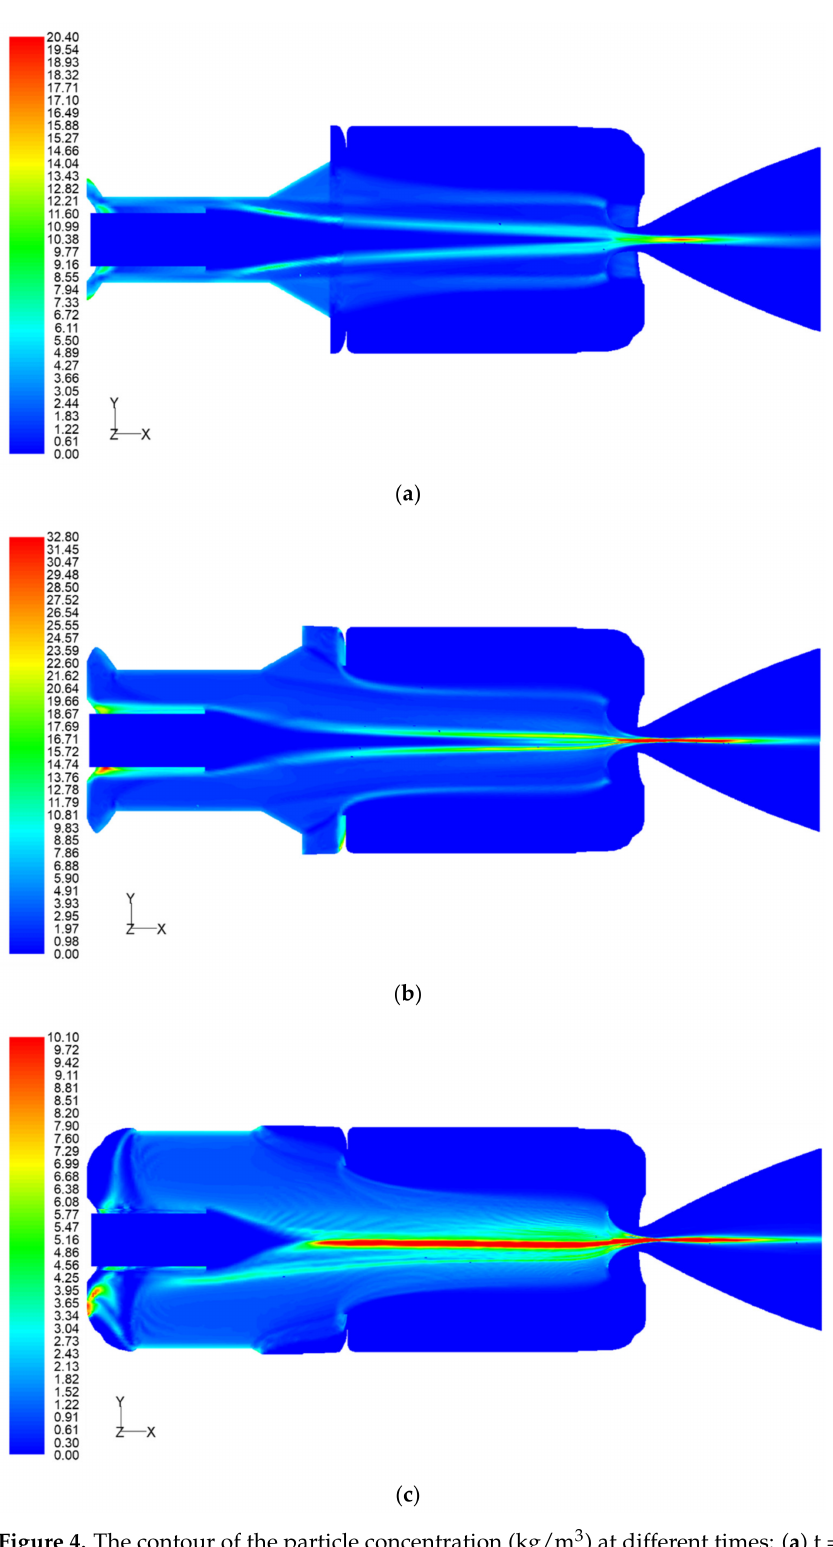
Figure 4. The contour of the particle concentration (kg/m 3 ) at different times: ( a ) t = 2 s; ( b ) t = 7 s; ( c ) t = 14